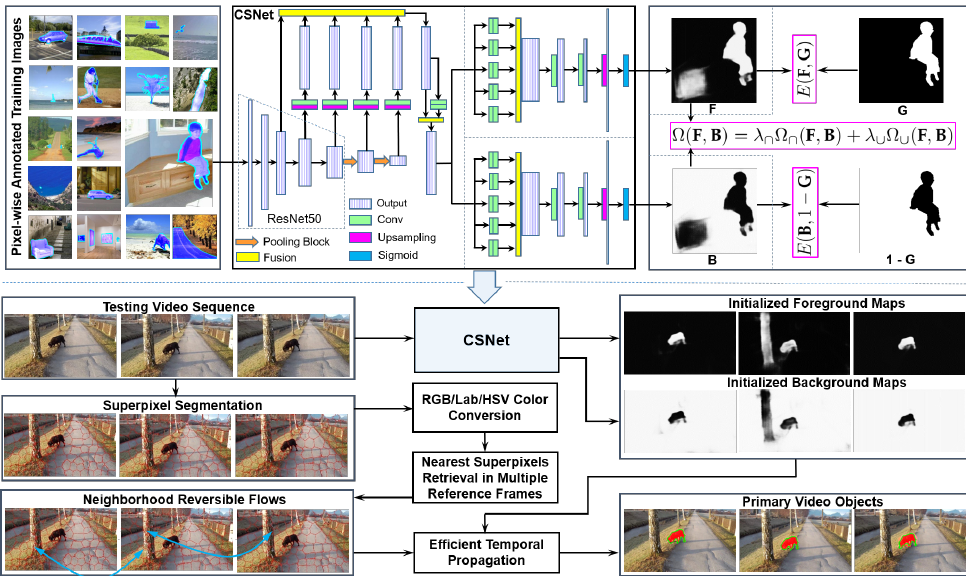
Figure 2. Framework of the proposed approach. The framework consists of two major modules. The spatial module trains CSNet to simultaneously initialize the foreground and background maps of each frame. This module operates on GPU to provide pixel-wise predictions for each frame. The temporal module constructs neighborhood reversible flow so as to propagate foregroundness and backgroundness along the most reliable inter-frame correspondences. This module operates on superpixels for efficient temporal propagation. Note that E ( · ) is the cross-entropy loss that enforce F → G and B → 1 − G . The proposed complementary loss Ω ( F , B ) contains intersection loss Ω ∩ ( F , B ) and union loss Ω ∪ ( F , B ) for a complementary constraint. F , B and G are foreground, background and groundtruth, respectively. λ ∩ and λ ∪ are corresponding weights. Moreover, more details about CSNet are shown in Section